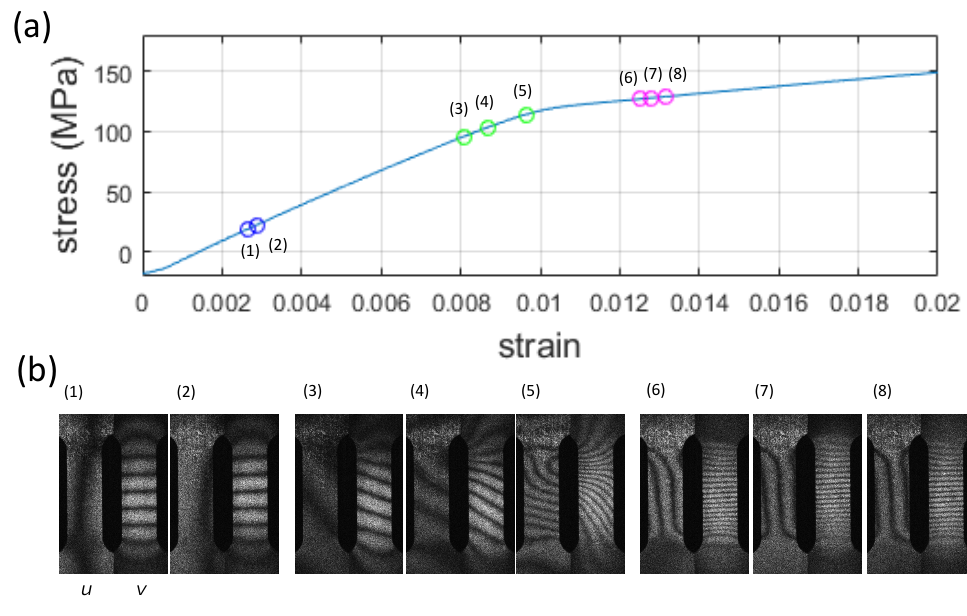
Figure 5. ( a ) Stress–strain curve and ( b ) fringe images representing contour of differential displacement in (1), (2): Elastic stage (Equations (14) and (15)); (3)–(5): pre-yield stage and (6)–(8) post-yield stages (Equations (16) and (17)). Numbers that are placed above fringe images correspond to numbers in stress-strain curve. For each pair of fringe images left is u -fringes and right is v